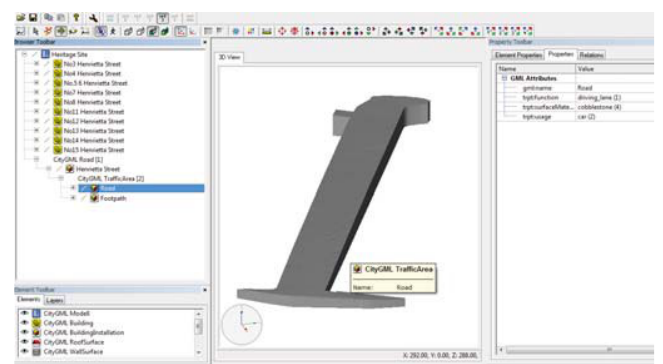
Figure 3: CityGML Model Showing Semantic Classes (Dore and Murphy 2012)